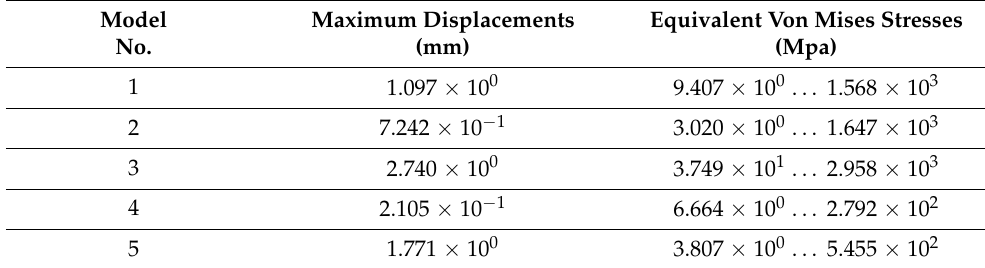
Table 3. Results from the Altair program